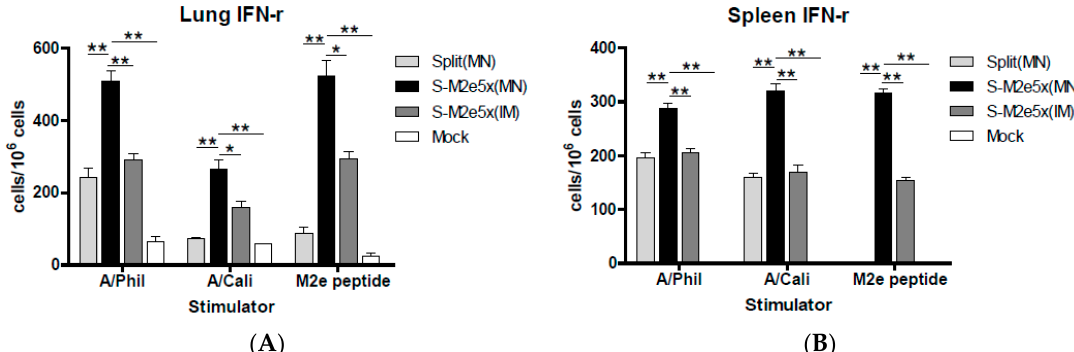
Figure 7. Systemic IFN- γ secreting cell spots after MN immunization upon heterosubtypic challenge. Splenocytes and lung cells were isolated from mice at day 4 post-challenge ( N = 4) with A/Philippines (H3N2). IFN- γ secreting cells were detected in the presence of A/Philippines/2/82 (H3N2) virus, A/California/04/09 (H1N1) virus, or M2e peptide as a stimulator (2 μ g/mL). ( A ) IFN- γ secreting lung cells. ( B ) IFN- γ secreting splenocytes. IFN- γ cytokine-producing cells were counted by ELISpot reader. Data represent mean ± SEM. IFN, interferon. MN: skin immunization by MN patch, IM: intramuscular needle injection immunization. One-way ANOVA and Tukey’s post-multiple comparison test were performed. *; p < 0.05, **; p < 0.01 between the marked groups.